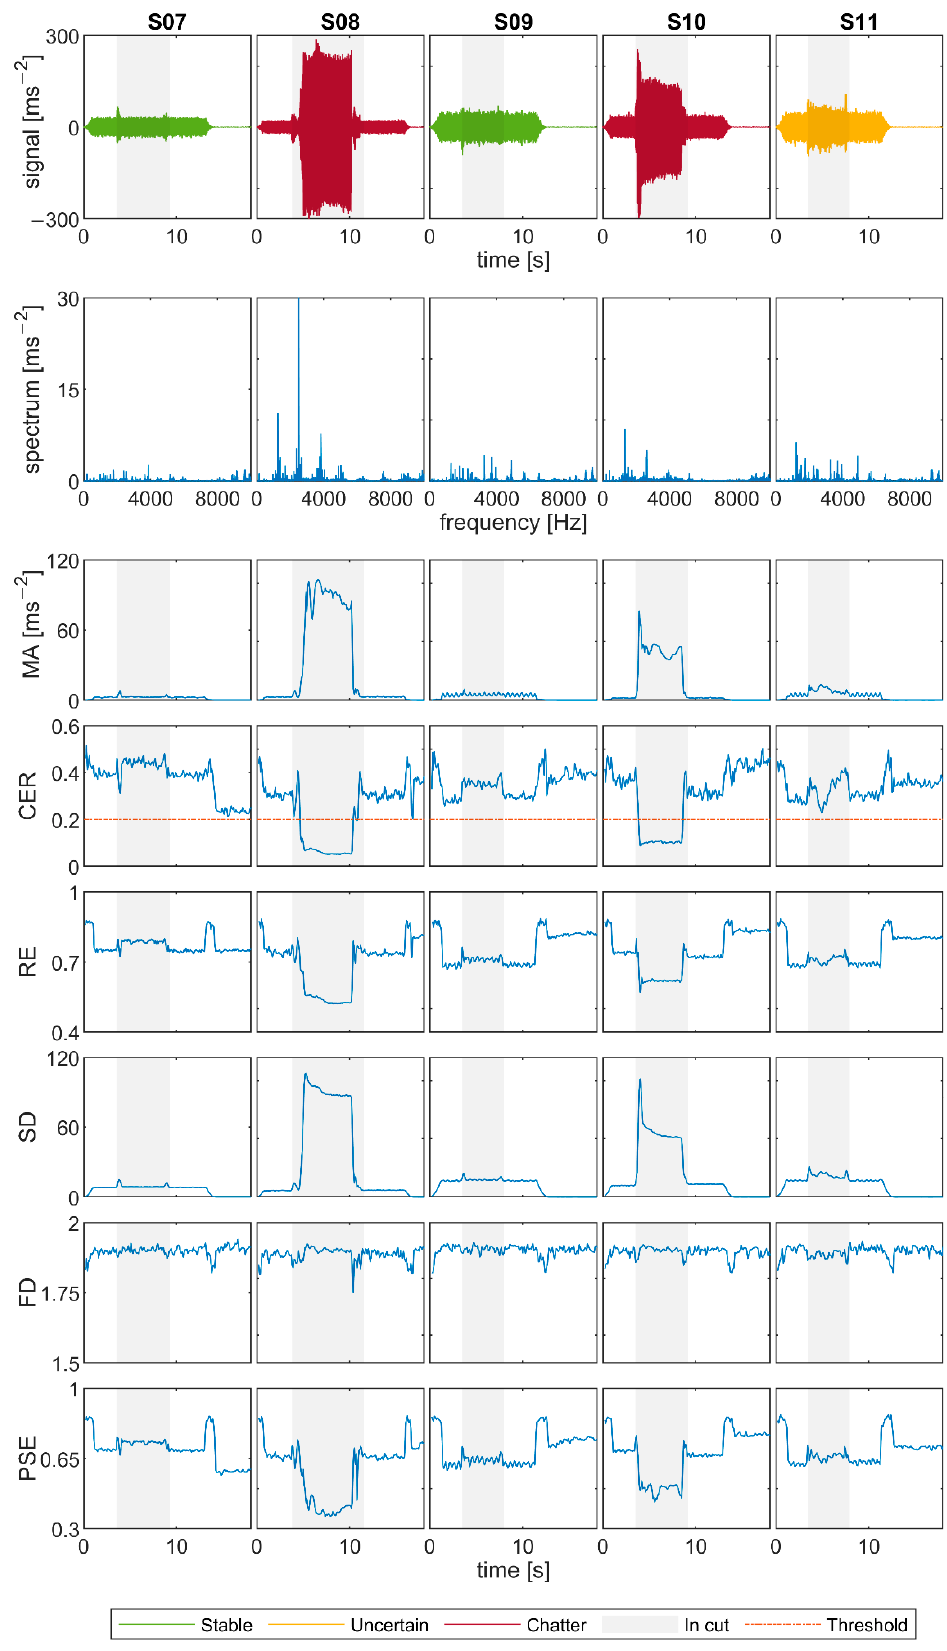
Figure A2. Signals from Experiment 2—slender end mill, overhang 30 mm.